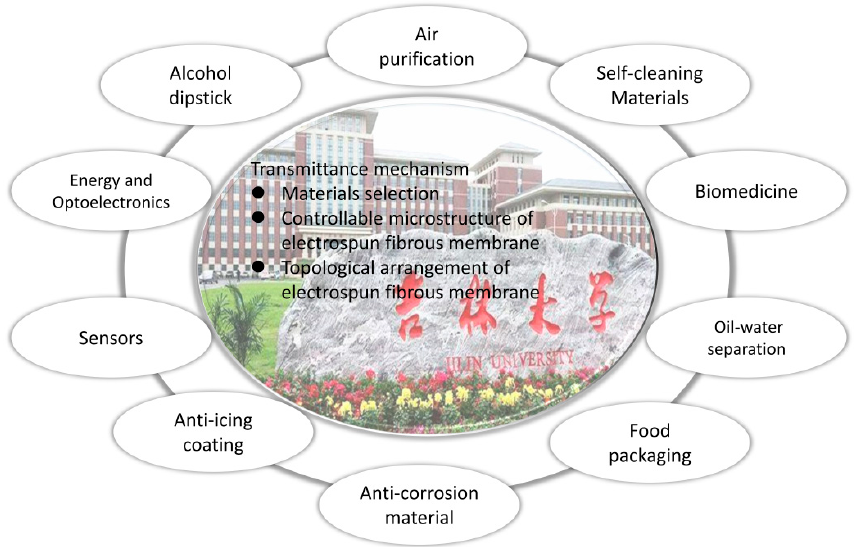
Figure 2. The applications of transparent as-spun membranes.